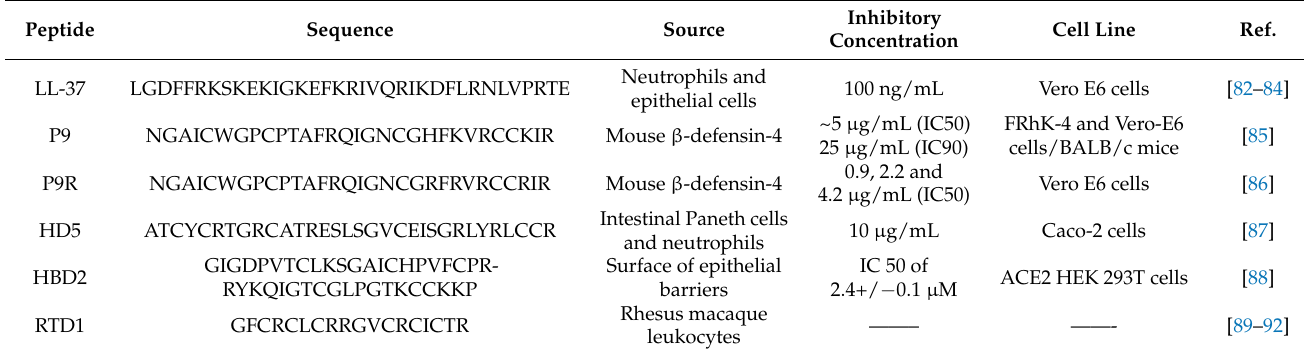
Table 1. Characteristics of defensins and LL-37 with potential inhibitory activity against Sars-Cov2. Peptide Sequence